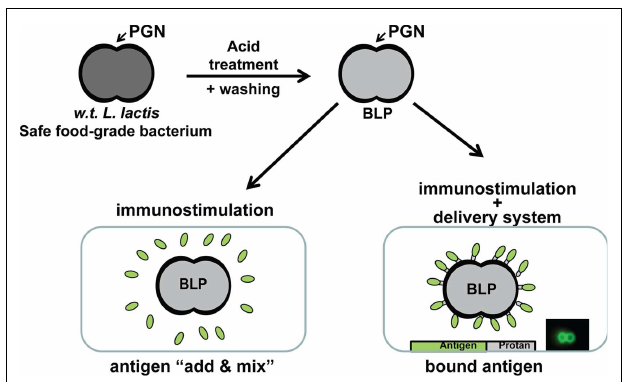
FIGURE 1 | Overview of the production and use of BLPs . After treatment in hot acid, degradation products and acid are removed by washing with phosphate buffered saline (PBS).The BLPs are finally formulated in PBS. Vaccines are made by BLPs admixed with antigens (this formulation is of particular interest for the reformulation of existing vaccines) or antigens are bound to the surface of the BLPs. For this latter format, it is a requirement that the subunit antigens are produced as a fusion protein with the Protan tag in a suitable production organism. Mixing of an antigen-Protan solution with BLPs results in instant, strong, and stable non-covalent binding such that BLPs are completely covered at the surface with the